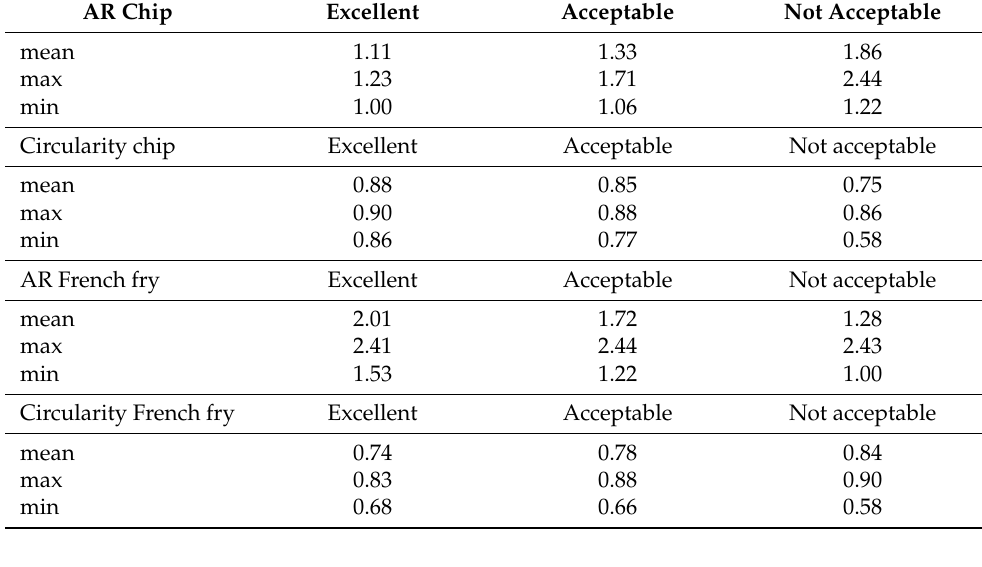
Table 1. Aspect Ratio (AR) and circularity mean, maximum and minimum values for Excellent, Acceptable and Not Acceptable tubers for French fry and chip market classes. Data is based on survey results of industry agronomists and potato growers.